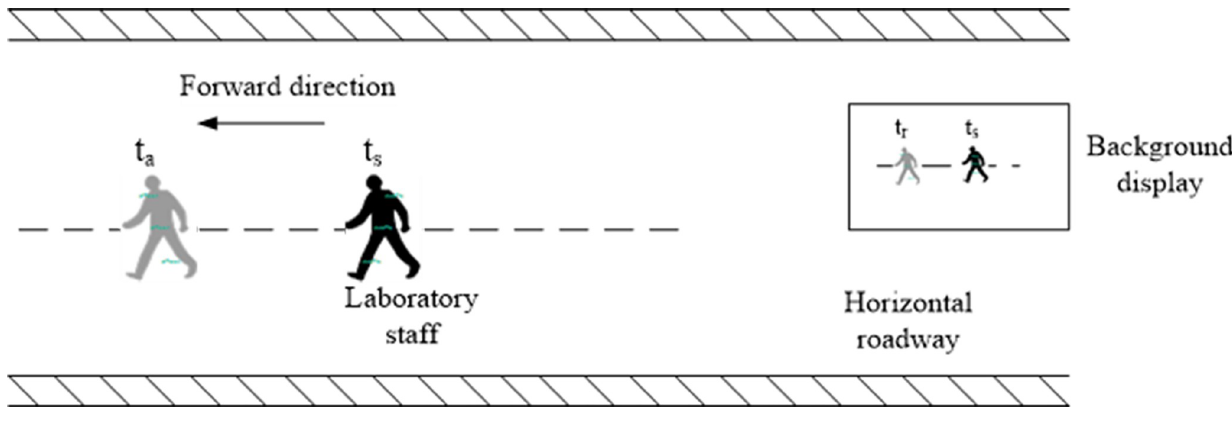
Fig 14. Schematic diagram of the positioning delay.